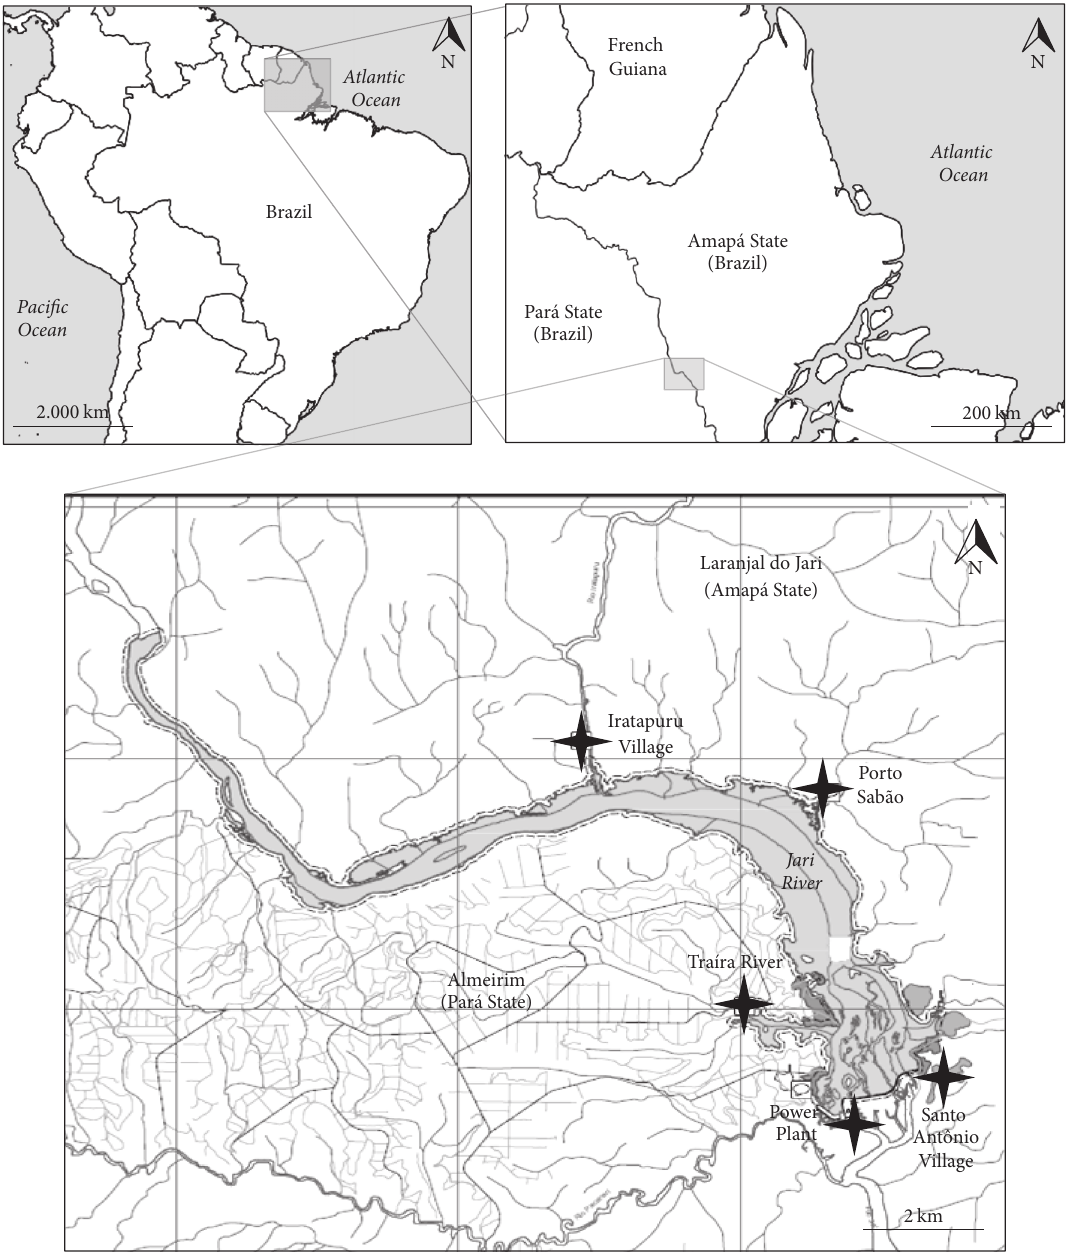
Figure 1: Study area. Maps showing the five surveyed locations for phlebotomine captures (2012–2015) in Santo Antˆonio do Jari hydroelectric system impacted area, between the states of Par´a and Amap´a, Brazil. M :